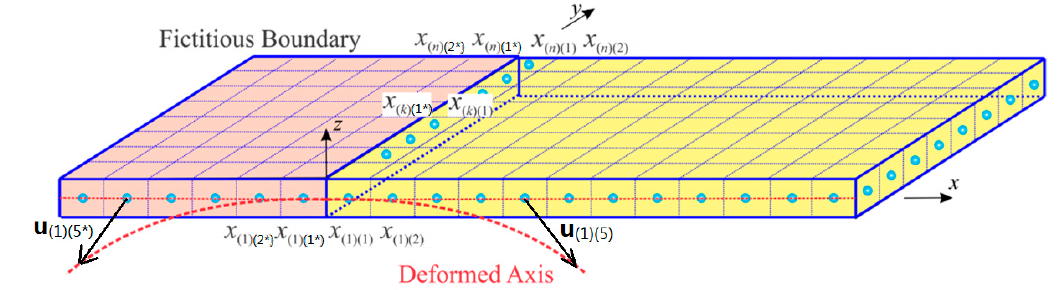
Figure B2. Application of clamped boundary conditions in peridynamic theory. Figure A3. Application of clamped boundary conditions in peridynamic